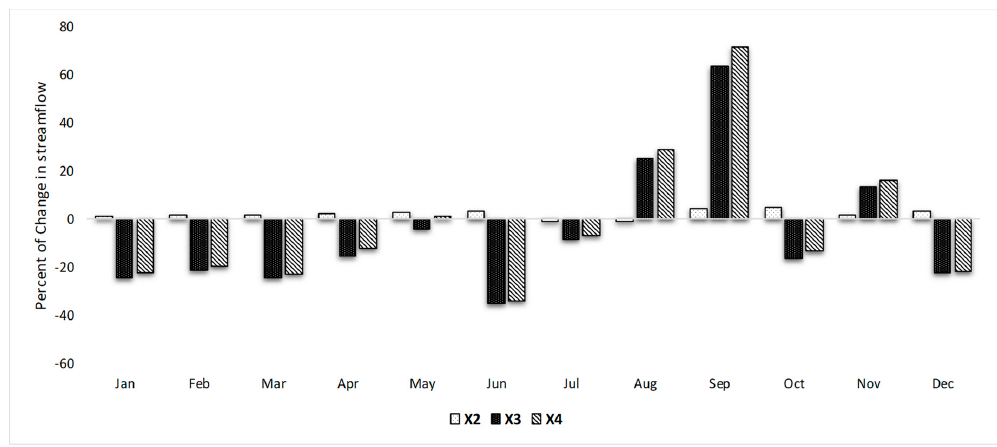
Figure 16. Absolute change in mean monthly streamflow for the Walzem Creek watershed under different scenarios.